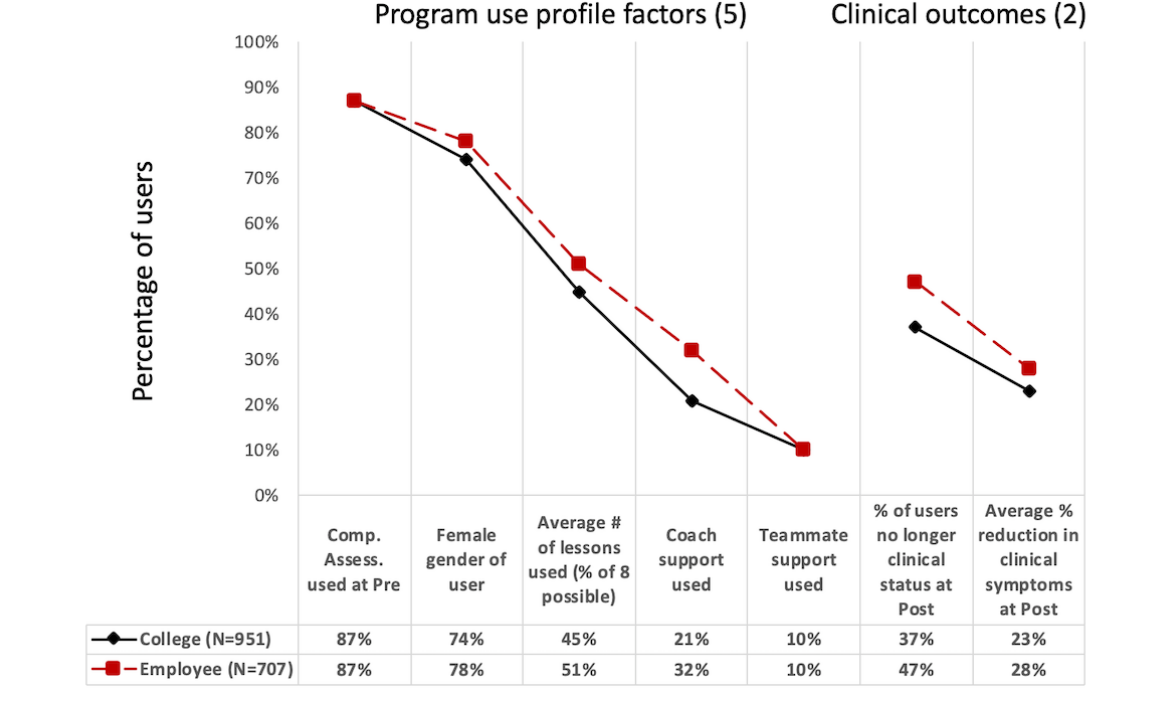
Figure 3. Comparison of college users and employee users of the same internet-based cognitive behavioral therapy programs on context factors and on clinical outcomes: both groups averaged across the 4